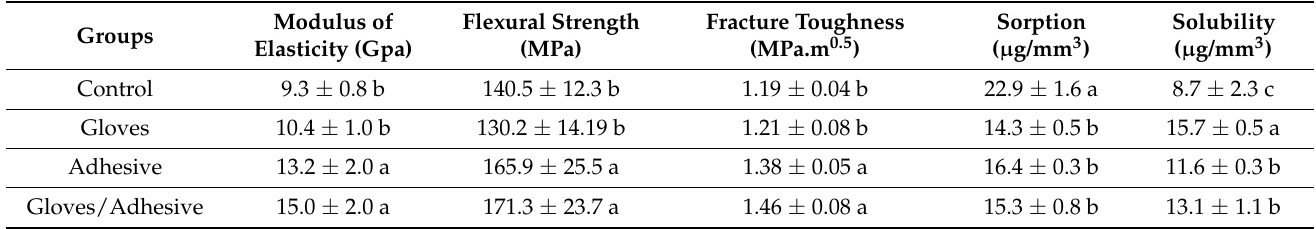
Table 2. Data (mean ± standard deviation) resulting from flexural strength (MPa), modulus of elastic- ity (Gpa), and fracture toughness (MPa.m 0.5 ) tests for composite resin specimens handled/modeled under different techniques (gloved-hands and/or adhesive) *.